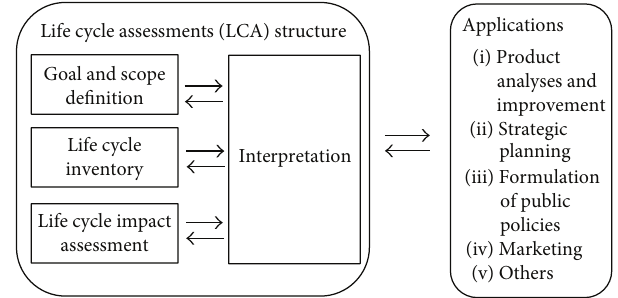
Figure 2: Methodological framework of LCA